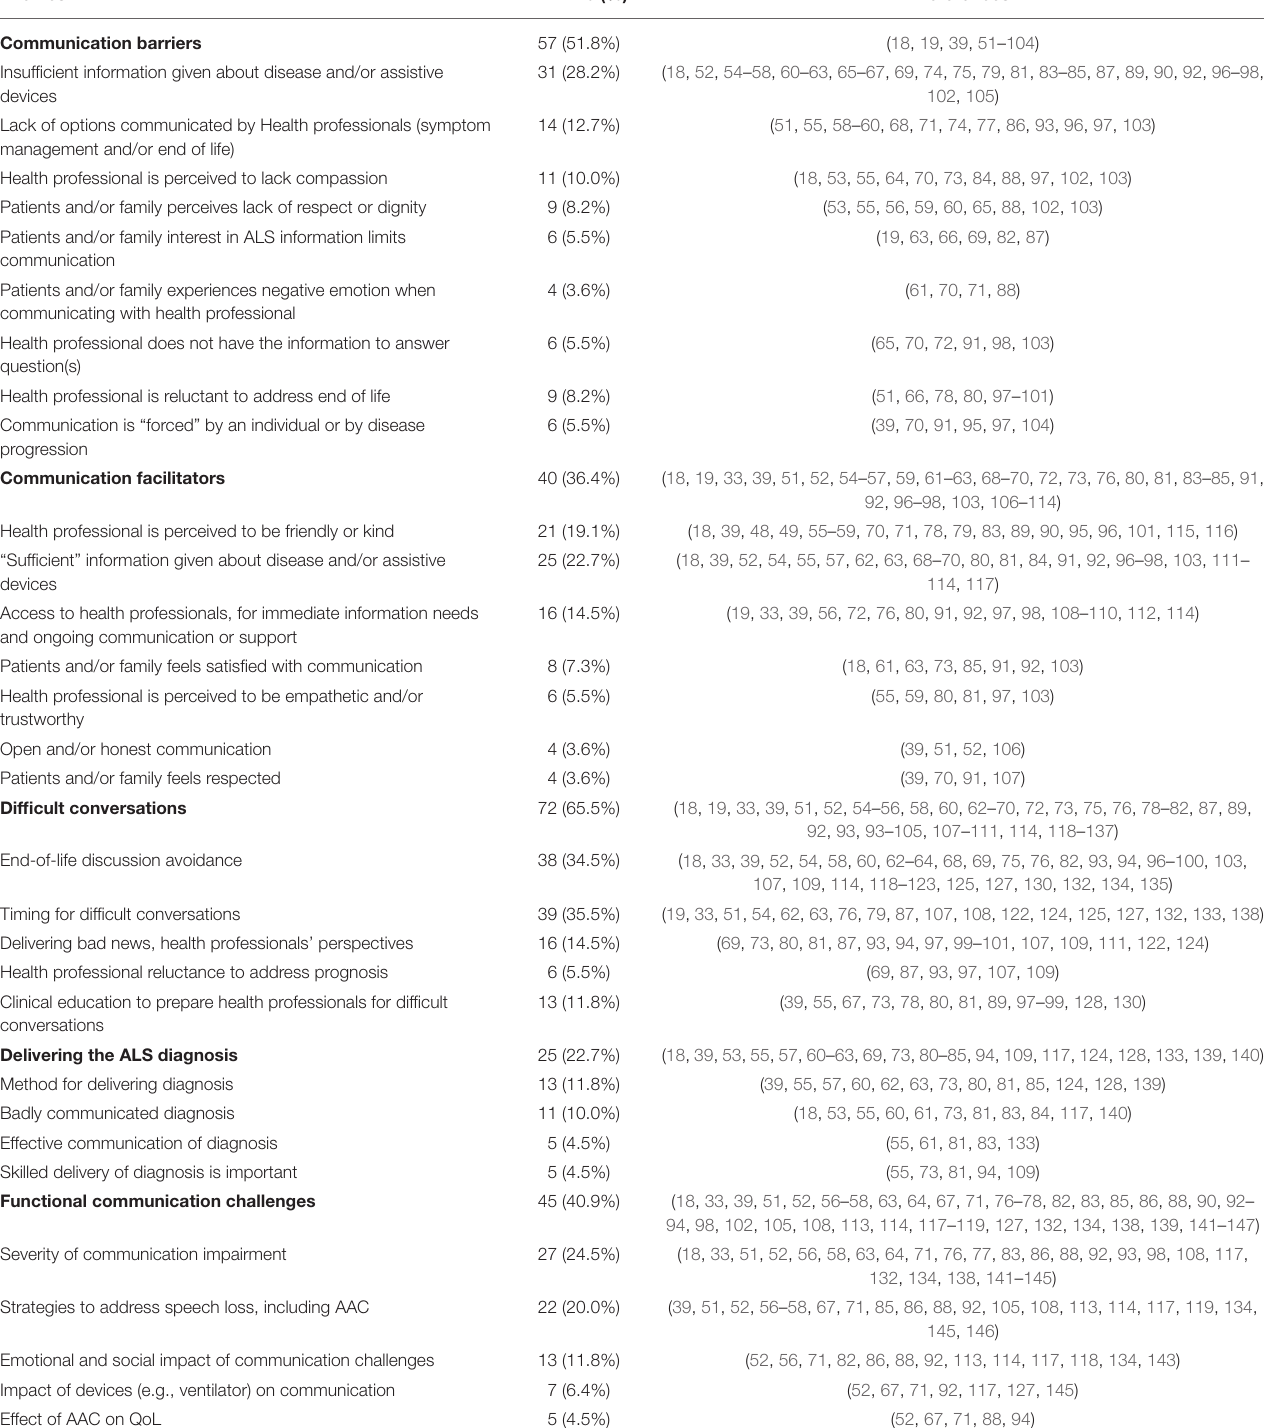
TABLE 5 | Themes identified in the health communication